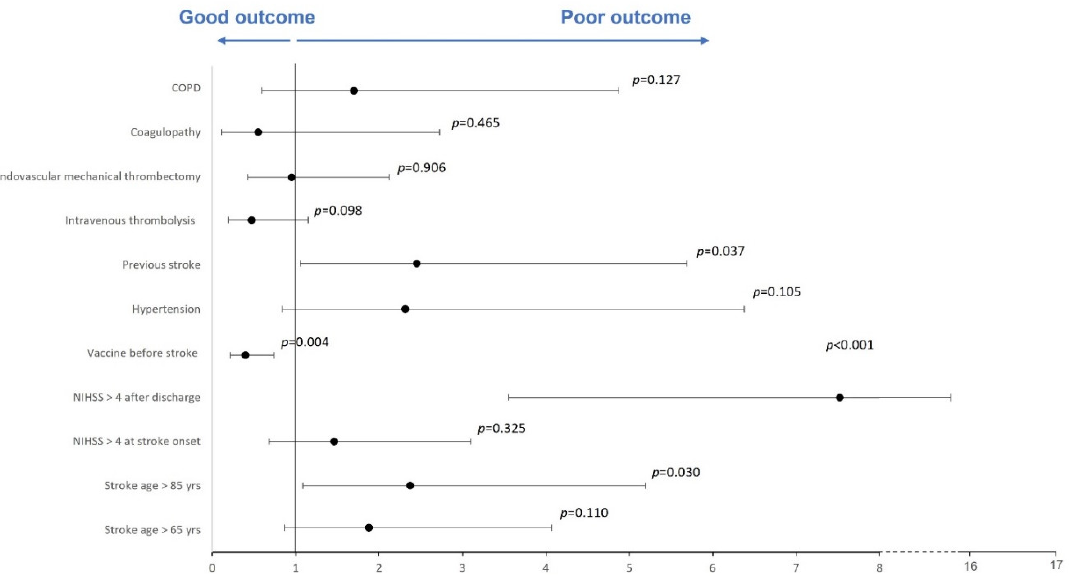
Figure 2. Forest plot of multivariate regression analysis evaluating outcome predictors. A forest plot of multivariable regression analysis evaluating risk factors, active COVID-19 vaccination, NIHSS score and age as predictors of a good or poor outcome. The Hosmer–Lemeshow test was not significant ( p = 0.878). Nagelkerke’s R2 was 0.524.